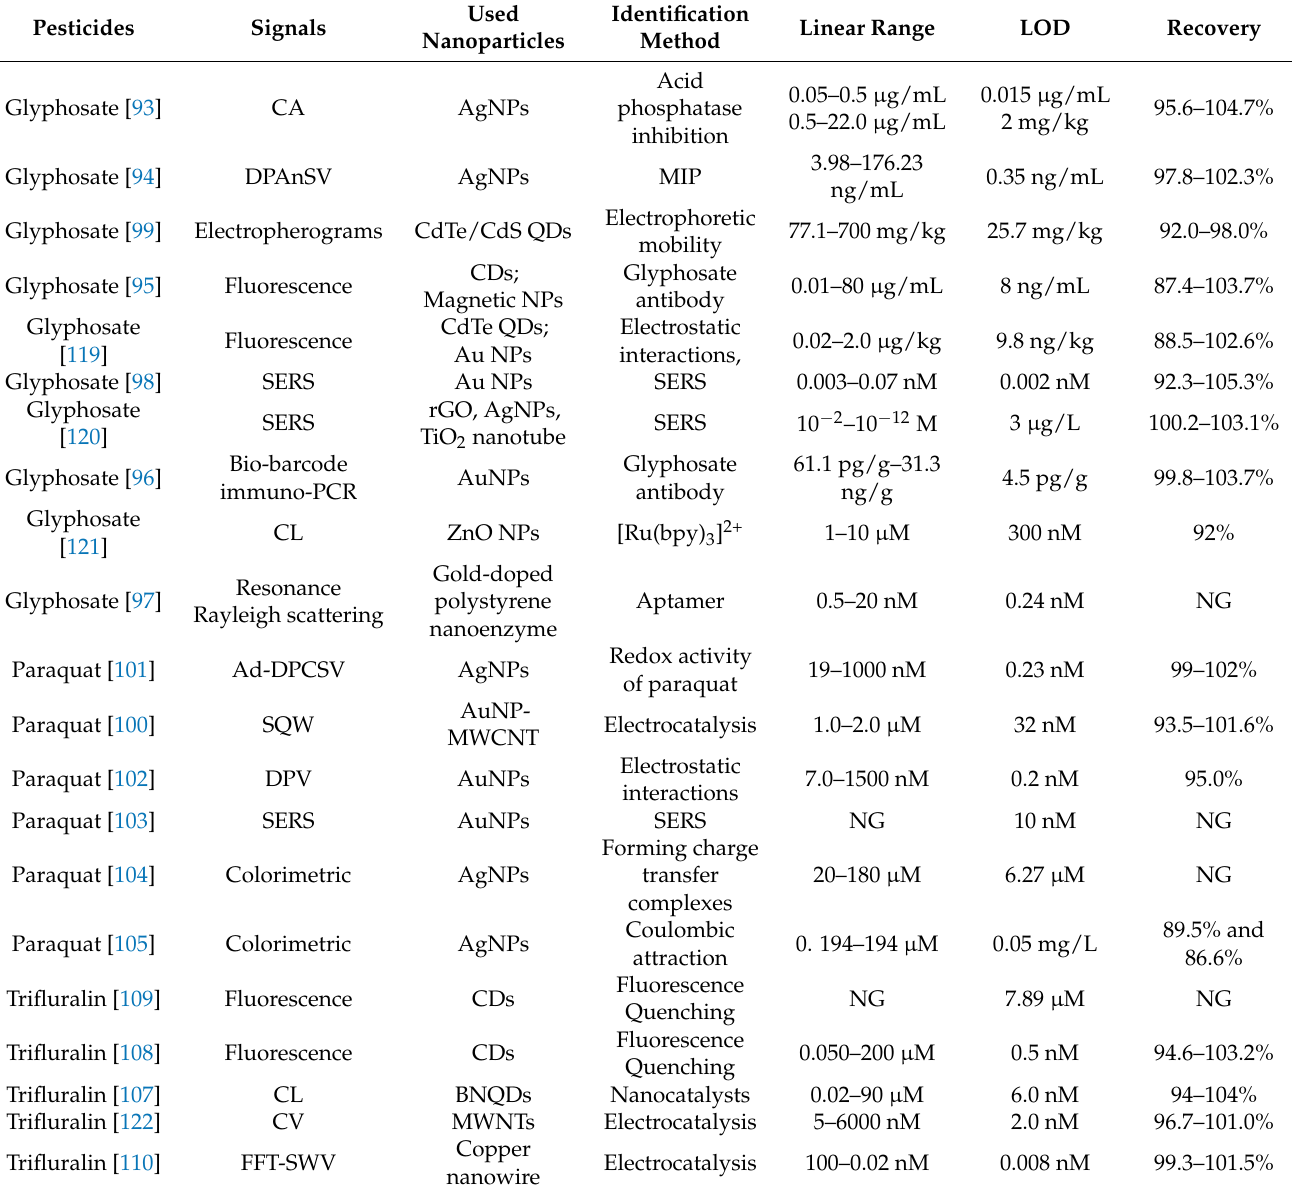
Table 2. The methods and their performances for the detection of